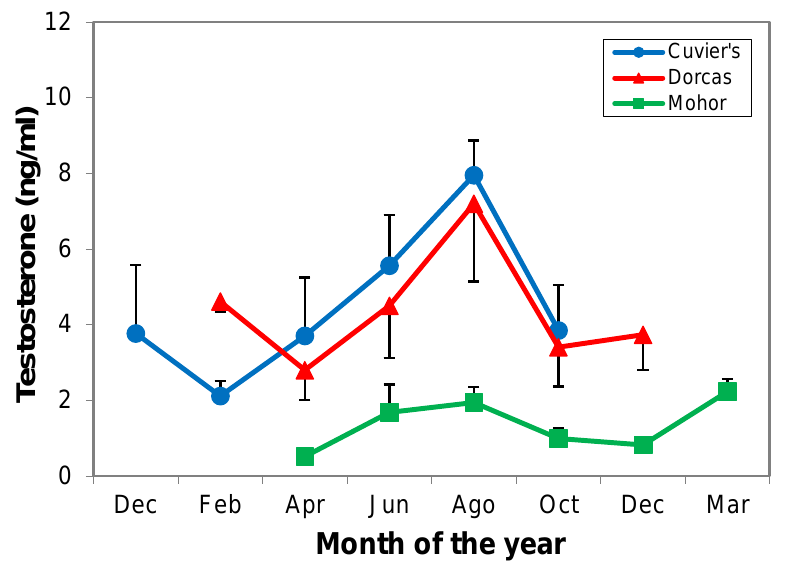
Figure 3. Testosterone levels in three species of gazelles from December 2000 to March 2002. n = 4 males per species.